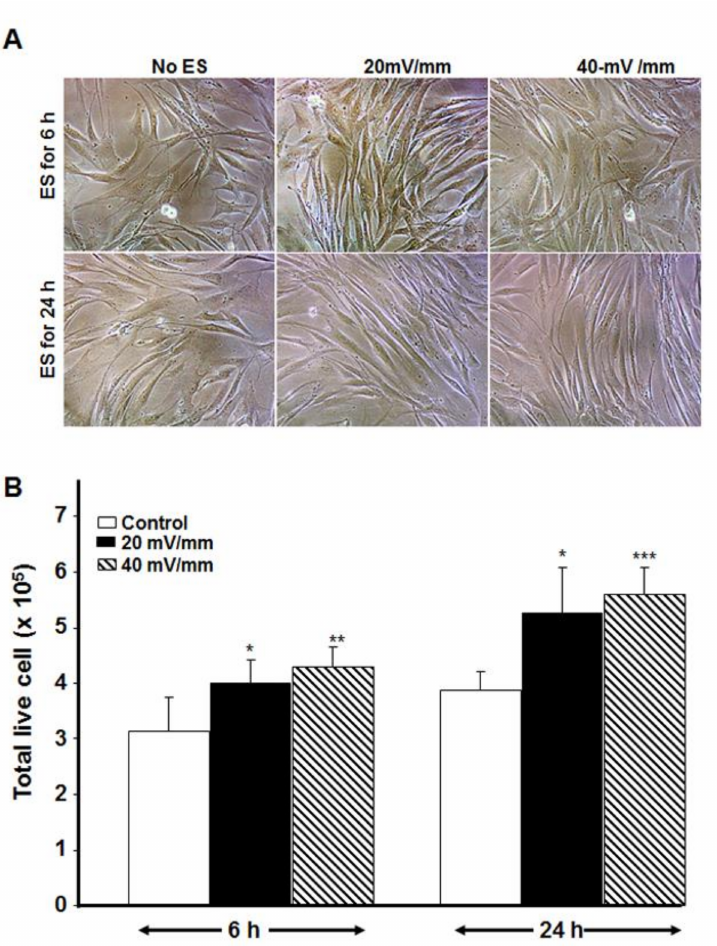
Figure 7. Effect of ES on DHSF subcultures. The ES-stimulated DHSF exhibited the same morphology as that observed in the control ( A ) but proliferated faster than those in the controls ( B ) up to 5 days post-ES. Results are means ± SD ( n = 4). * p < 0.05, ** p < 0.01, *** p <